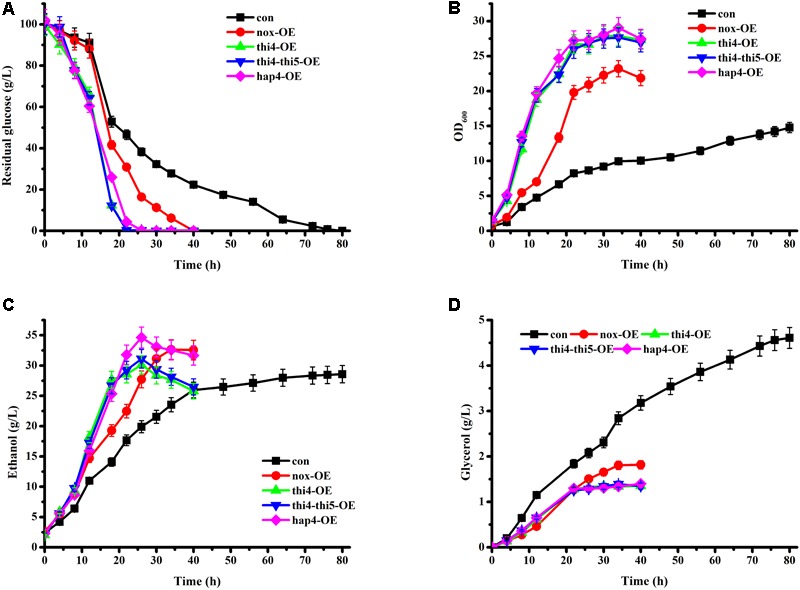
Time course analyses of parameters of batch fermentation by recombinant strains. (A) Residual glucose; (B) OD600; (C) ethanol; (D) glycerol.